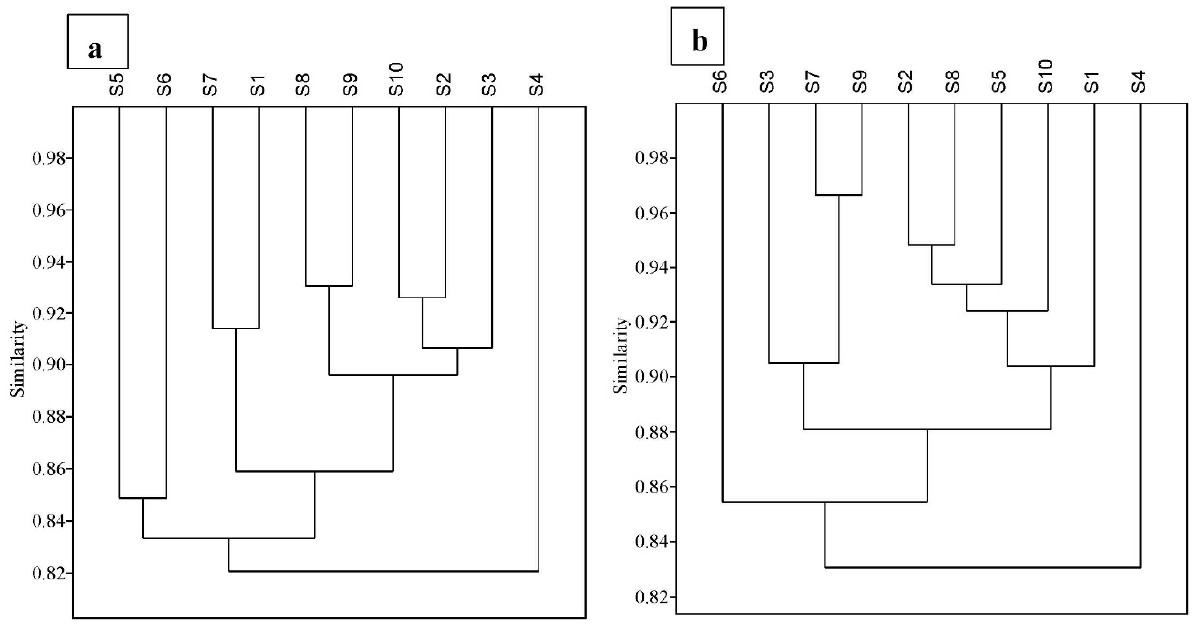
Figure 4. Dendrogram showing clusters based on the Bray–Curtis similarity matrix for ( a ) December and ( b ) February.